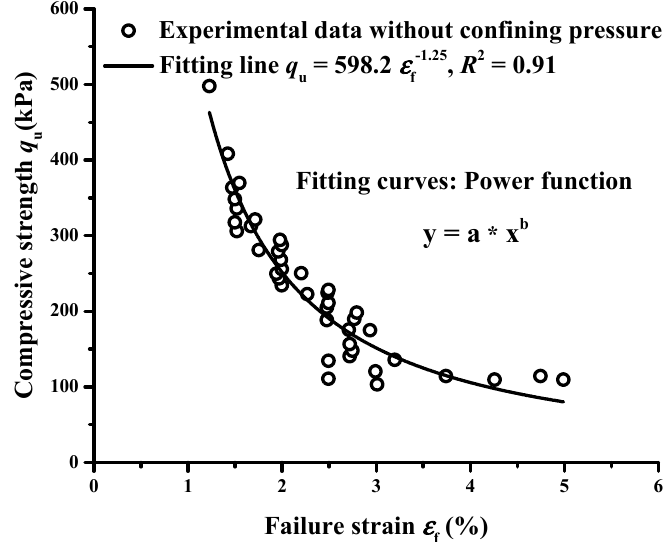
Figure 11. Relationship between compressive strength and failure strain without confining pressure.